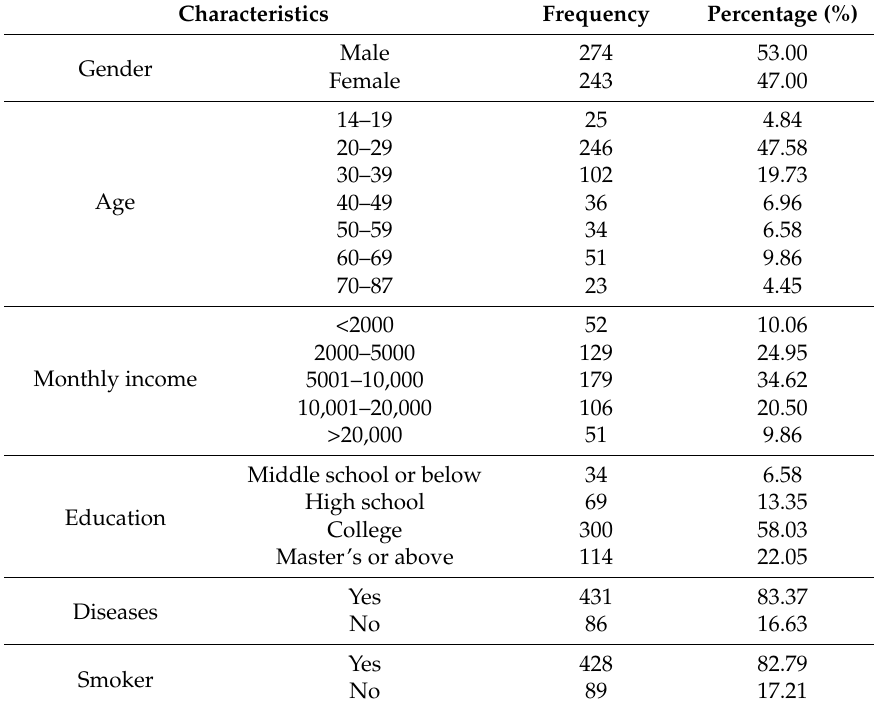
Table 1. Distribution of sample